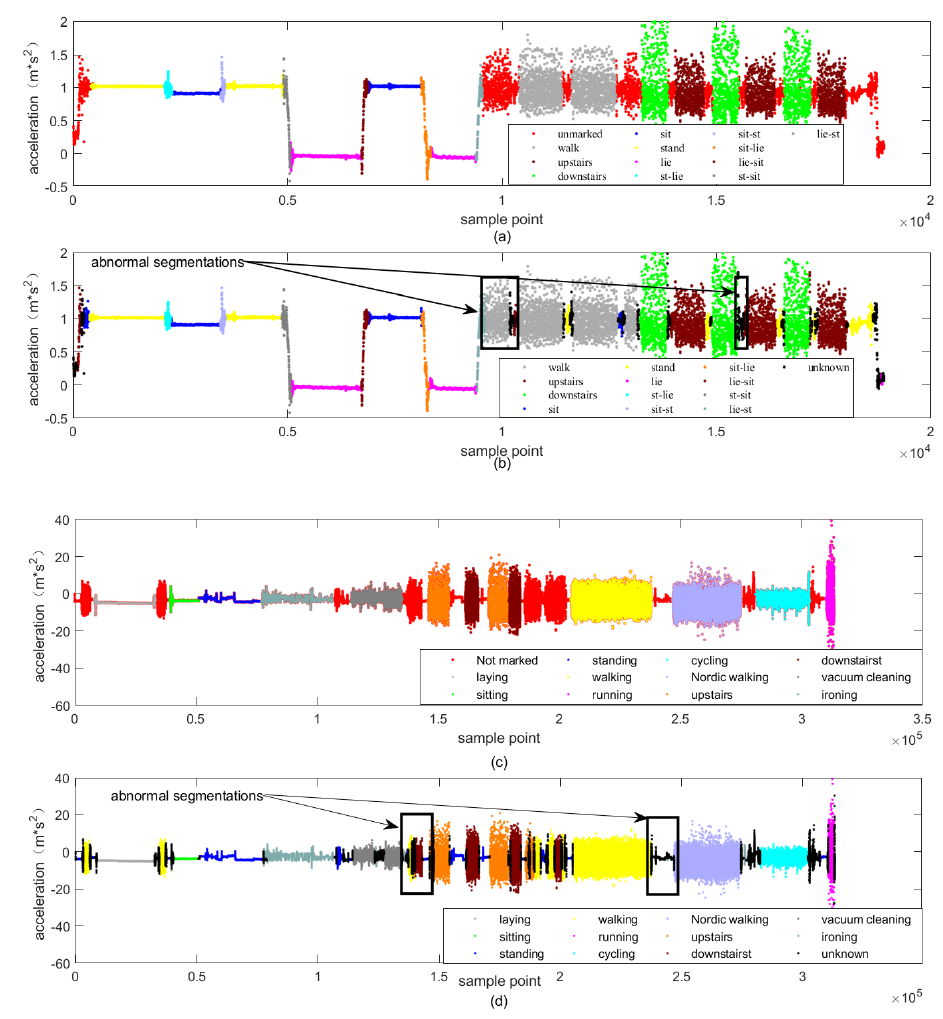
Figure 13. Scatter comparison of x-axis acceleration of the proposed model on different data sets. ( a ) Ground truth of the UCI data set, ( b ) prediction results of the UCI data set, ( c ) ground truth of the PAMAP2 data set, and ( d ) prediction results of the PAMAP2 data